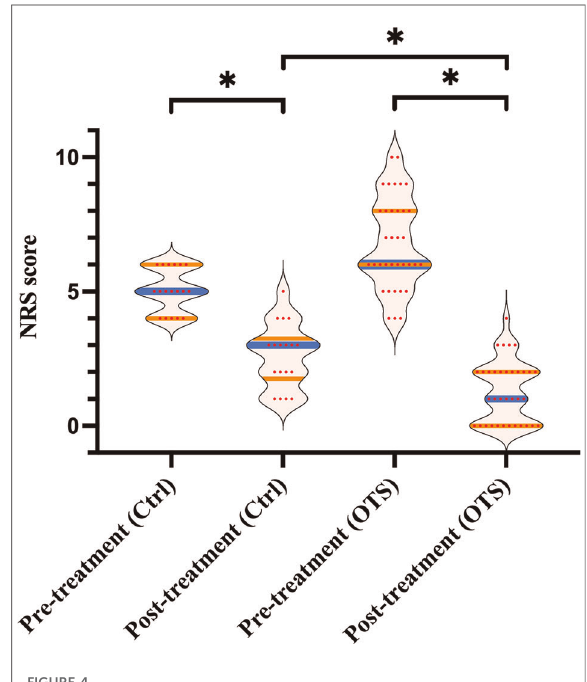
FIGURE 4 The NRS score